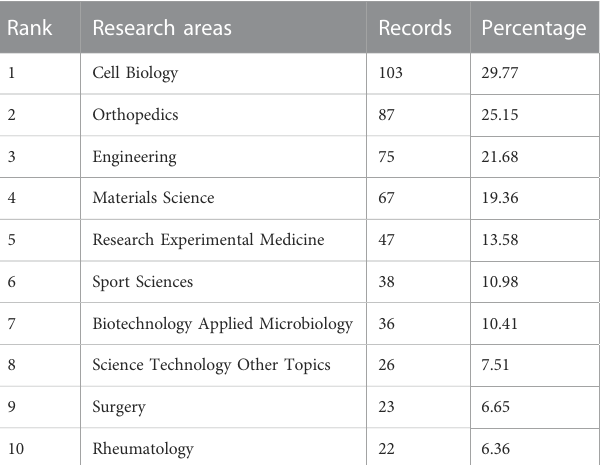
TABLE 6 The top 10 well-represented research areas.